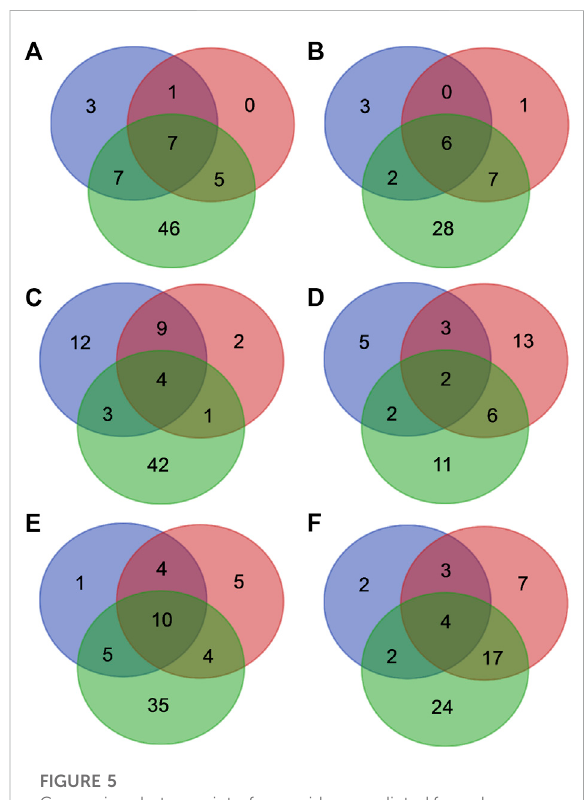
FIGURE 5 Comparison betweeninterfaceresiduespredictedfromdeep sequencing data, homology models and AlphaFold2 models for the MazEF systems. Venn diagram showing the overlap between the residues predicted to be a part of the interface from the deep sequencing data (blue circle), homology (red circle) and AlphaFold2 (green circle) models of (A) MazE3, (B) MazF3, (C) MazE6, (D) MazF6, (E) MazE9 and (F)